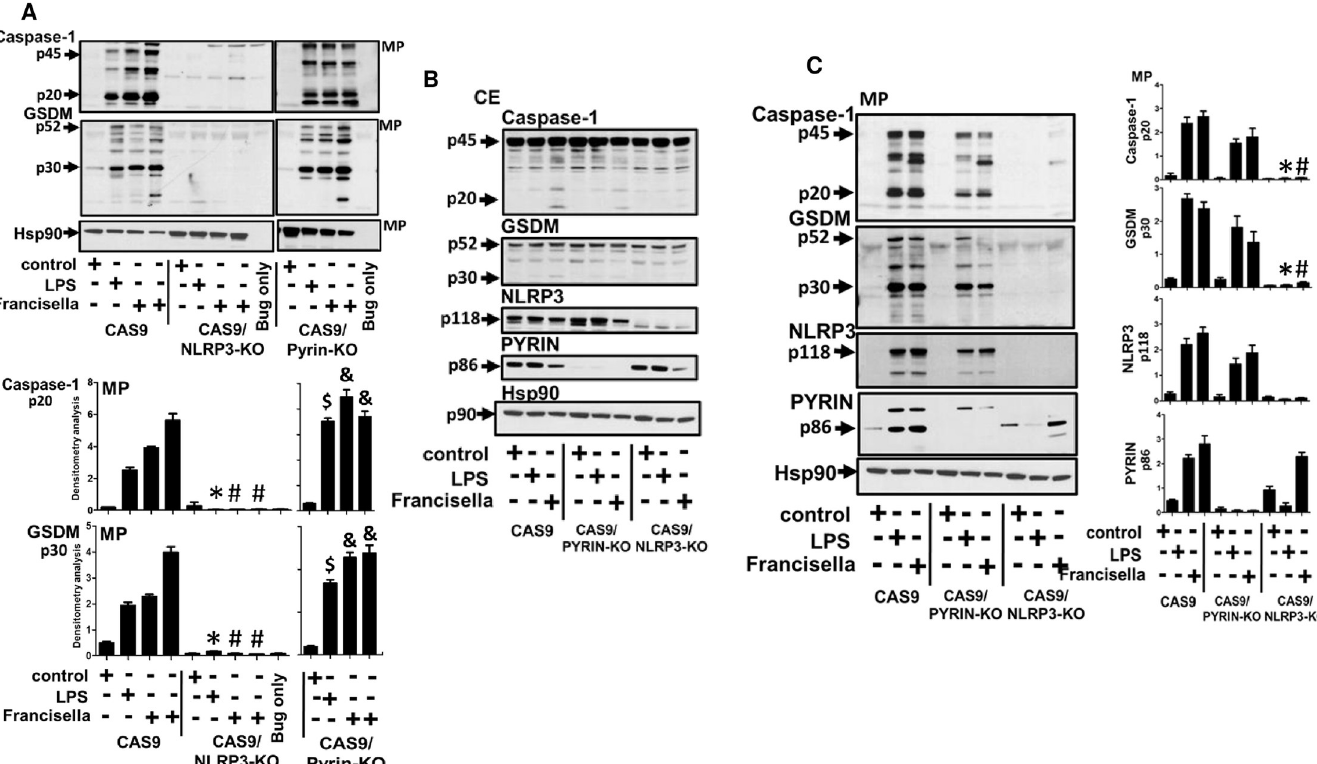
Fig 1. Microparticle caspase-1 and GSDM-D release by Francisella regulated by NLRP3 and not Pyrin. A) Microparticles (MP) fractions were isolated from CAS9, CAS9/NLRP3-KO and CAS9/PYRIN-KO cells stimulated with LPS (1 μ g/ml) for 2h or left untreated, Francisella (25MOI) for 2h, 4h or left untreated. Microparticulate p20 caspase-1 and p30 GSDM-D release was abrogated in NLRP3 KO by both LPS and Francisella , but not in PYRIN-KO when compared to CAS9 cells. � # CAS9 vs CAS9/NLRP3 KO; $ & CAS9/NLRP3 KO vs CAS9/PYRIN KO. B) Cell lysates were analyzed and confirmed for NLRP3 and Pyrin, as well as effects on pro-caspase-1 and pro-GSDM-D. C) Cells were treated with LPS or Francisella overnight (17h) and analyzed for the presence of active p20 caspase-1 and cleaved GSDM-D. Overnight experiments were performed to allow internalization of Francisella and thereby induce downstream signaling mediated by internalized Francisella . � # CAS9/PYRIN KO vs CAS9/NLRP3 KO. Immunoblot data is representative of n = 4